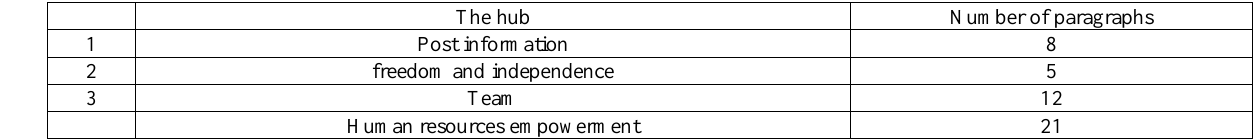
Table 8. Axes Empowering Human